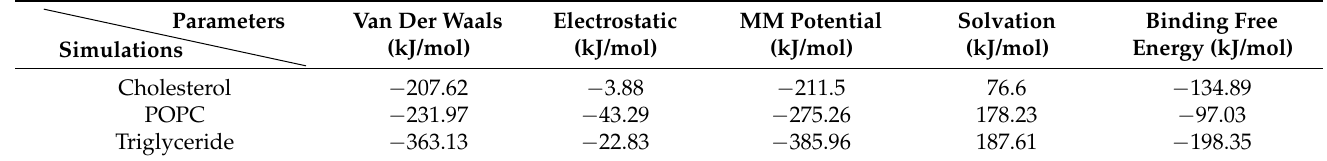
Table 3. Time average (from 800 to 900 ns) energy parameters for amylose-lipid complexes. SimulationsParameters